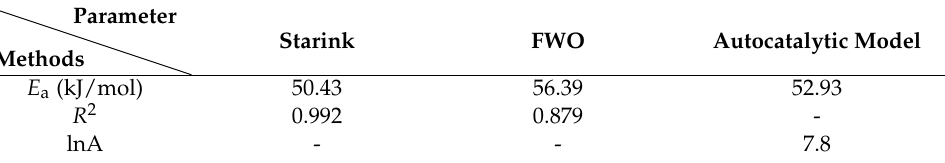
Figure 6. E a fitting curves of the LiTFSI-LiODFB electrolyte by FWO method for conversion degree from 0.10 to 0.95. Table 4. Thermokinetic parameters of LiTFSI-LiODFB dual-salt electrolyte calculated by different kinetic methods and simulation.